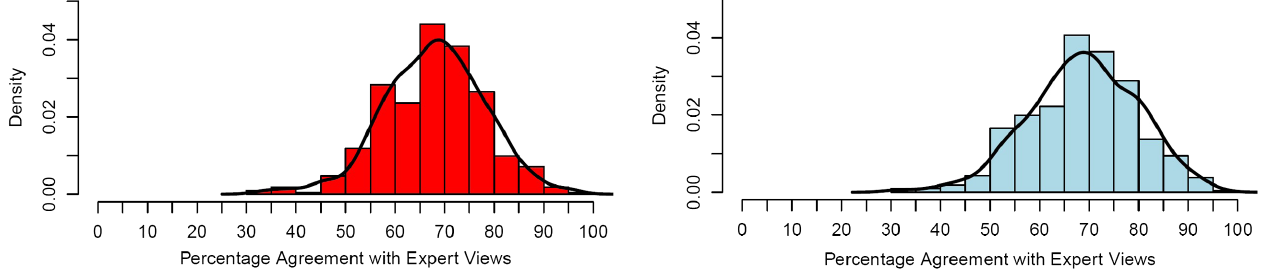
FIG. 4. Score distributions of pre (left) and post (right) responses to proposed 11-item instrument — bolded line represents the density curve for each histogram.